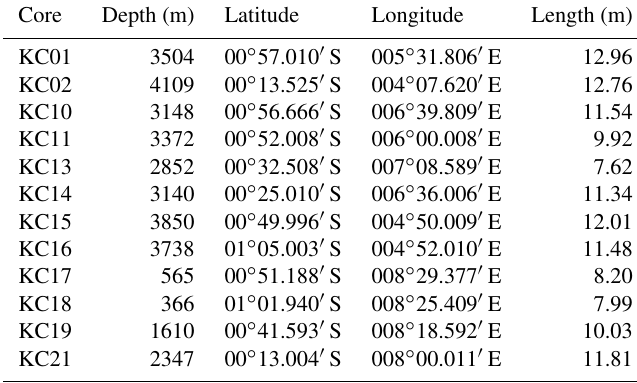
Table 1. Characteristics of the 12 studied cores (MOCOSED 2010 cruise). Core Depth (m) Latitude